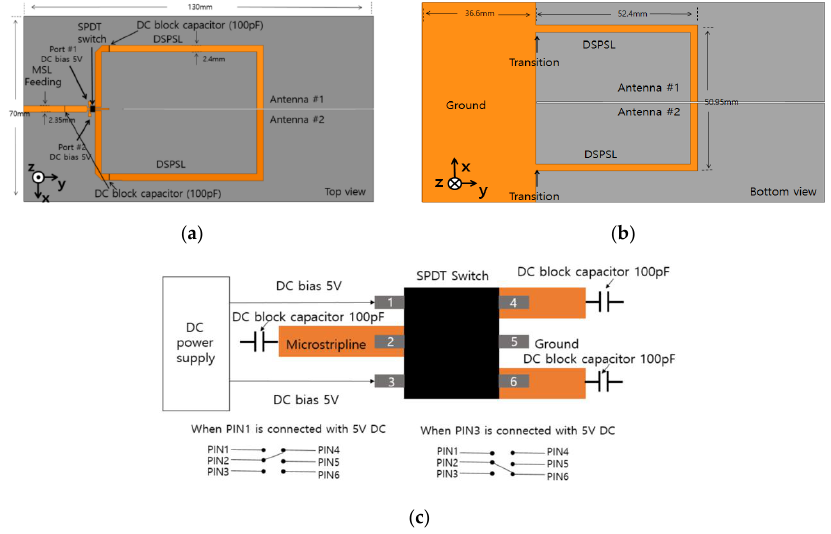
Figure 4. Layout of switching network; ( a ) top view and ( b ) bottom view ( c ) single-pole-double-throw (SPDT) switch with bias network.